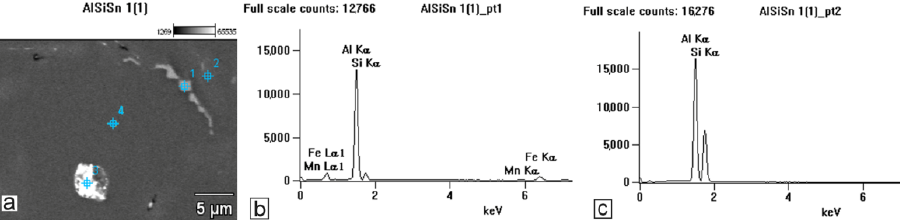
Figure 11. SEM-EDS analysis of microstructure and chemical composition of Si10Sn0.2 alloy: ( a ) image of microstructure with points of analysis; ( b ) plot of spectra in Area 1; ( c ) plot of spectra in Area 2.